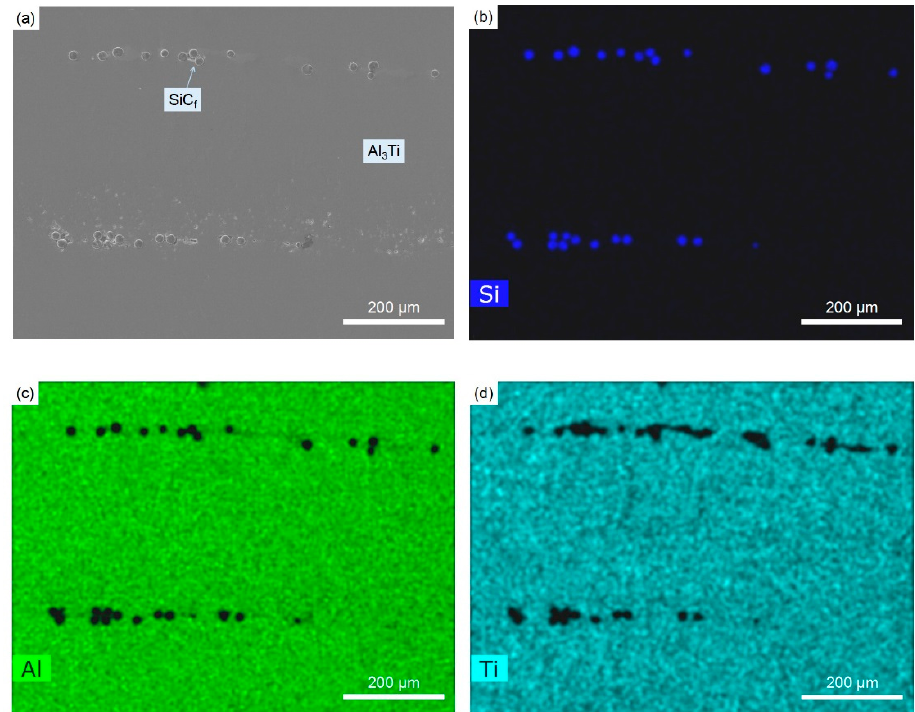
Figure 12. ( a ) The SEM image and ( b )–( d ) the element distribution maps of Si, Al, and Ti in the Ti-(SiC f /Al 3 Ti)-laminated composite.